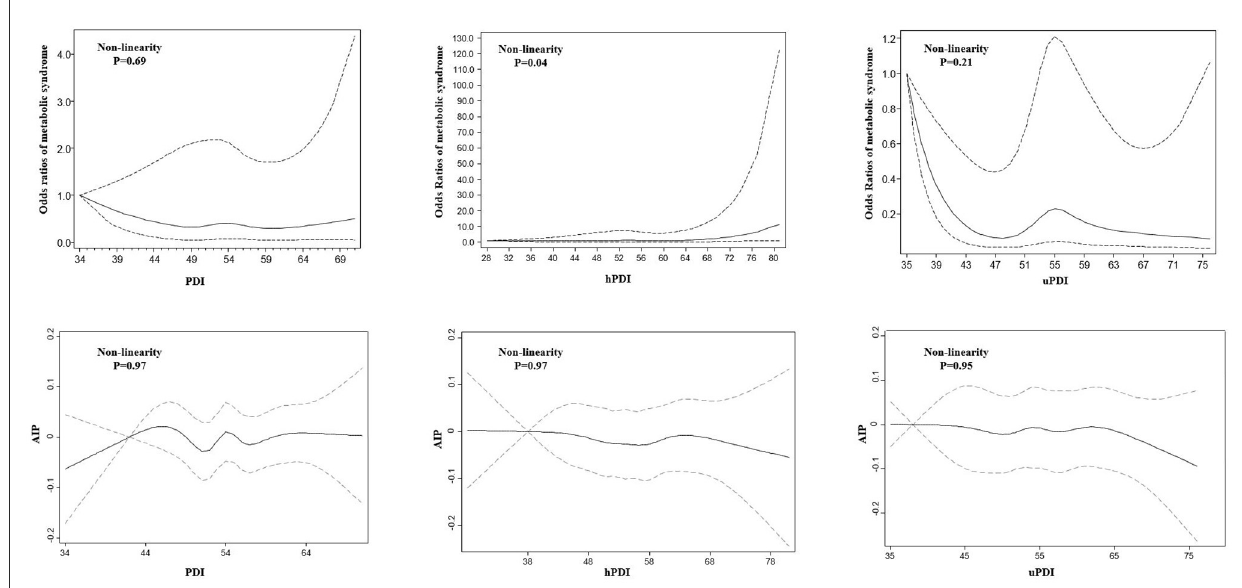
FIGURE2 The non-linear association of all types of plant-based diet indices with MetS and AIP.